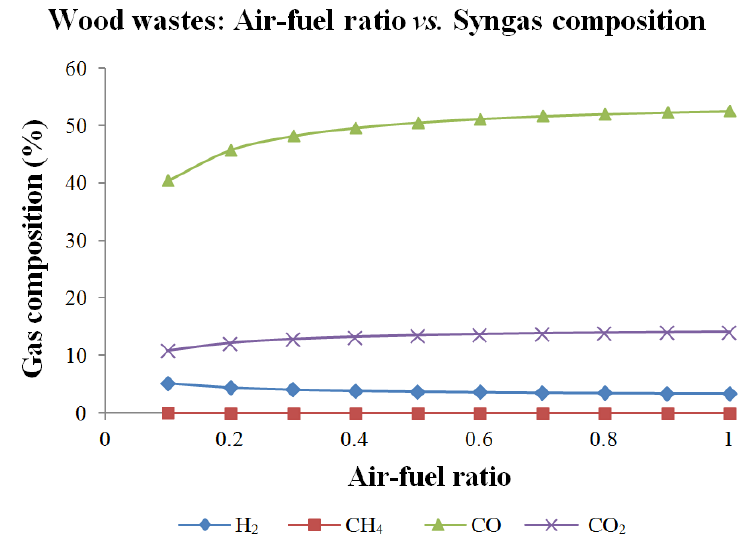
Figure 4. Effect of air-fuel ratio for wood wastes (gasifier temperature: 700